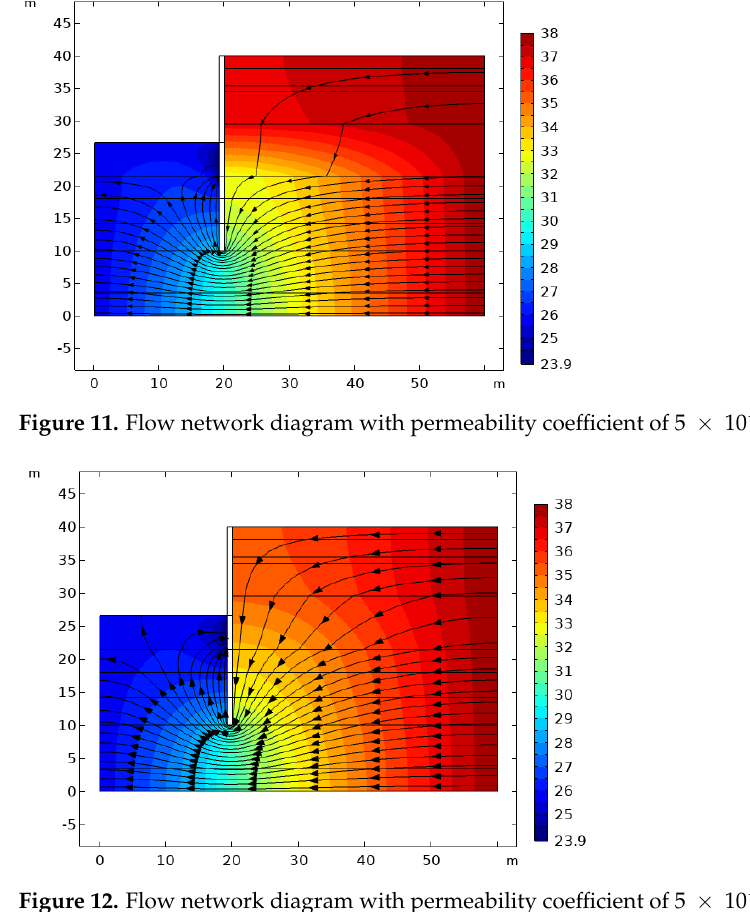
Figure 12. Flow network diagram with permeability coefficient of 5 × 10 -1 m·d -1 .